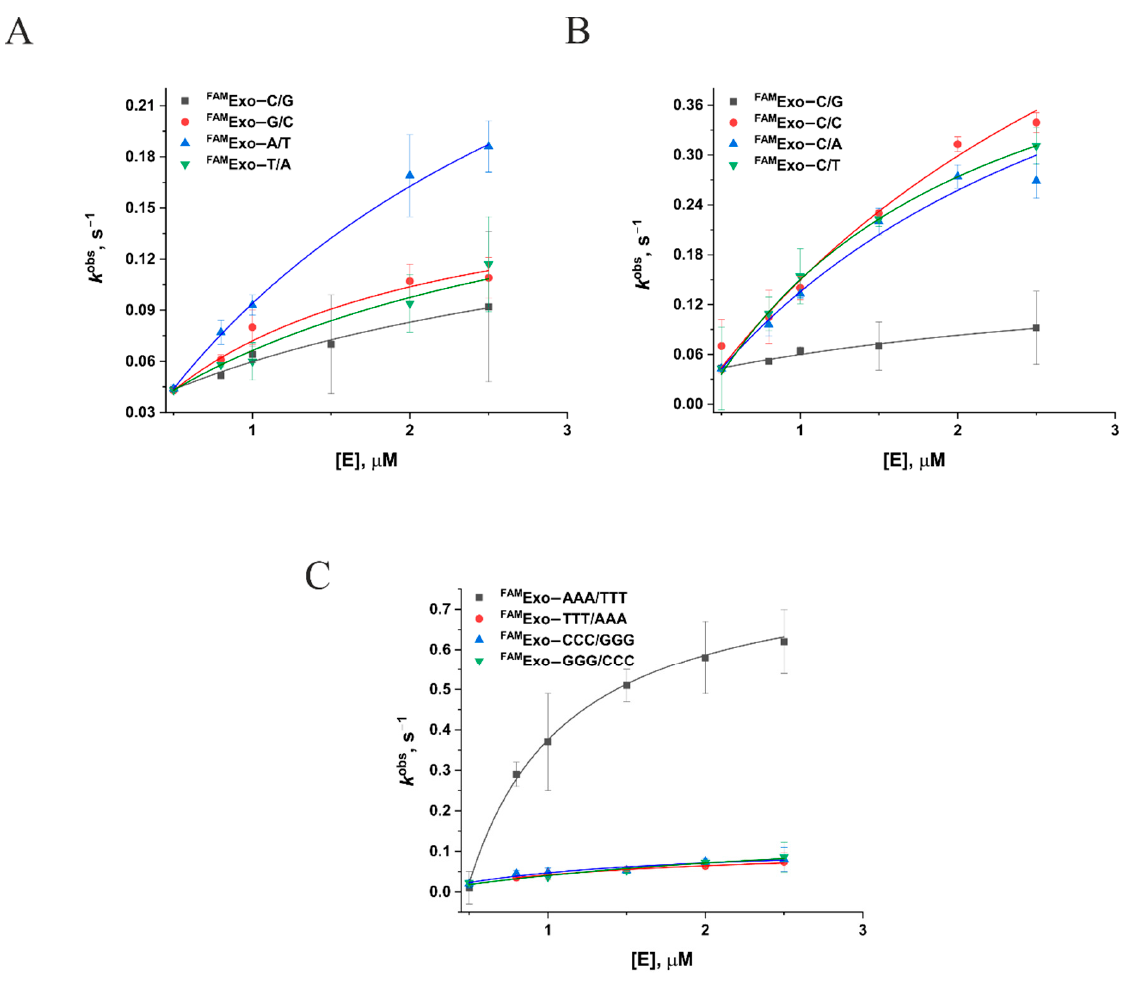
Figure 4. Dependence of the observed rate constant ( k obs ) for the formation of 16–mer product S–1 on enzyme concentration for different substrates. ( A ) Fully complementary substrates. ( B ) Substrates containing noncanonical terminal pairs C/A, C/T, and C/C in comparison with C/G. ( C ) Substrates FAM Exo–XXX/YYY with a terminal triad of the same nucleotide. ([DNA] = 1 μ M, T = 37°C).